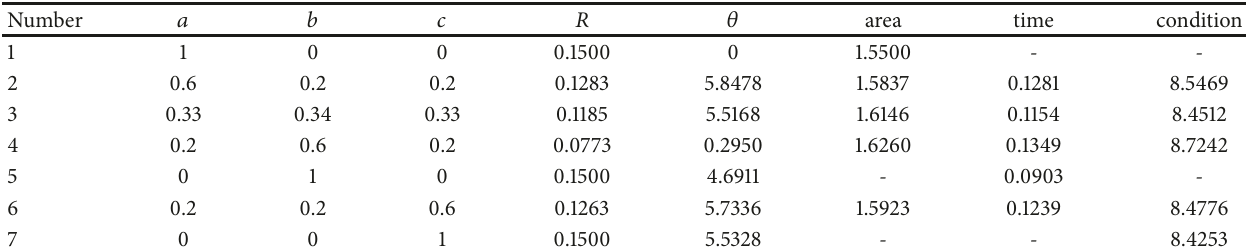
Table 5: Optimization results with different weight coefficients.